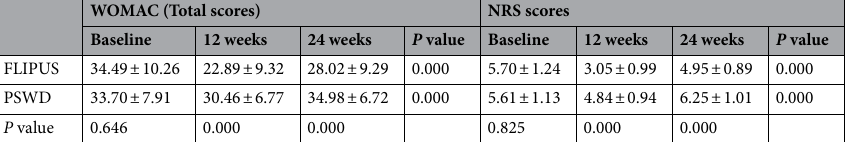
Table 4. WOMAC total score and NRS score measures after 12 and 24 weeks of follow-up. FLIPUS focused low-intensity pulsed ultrasound; PSWD pulsed shortwave diathermy, WOMAC Western Ontario